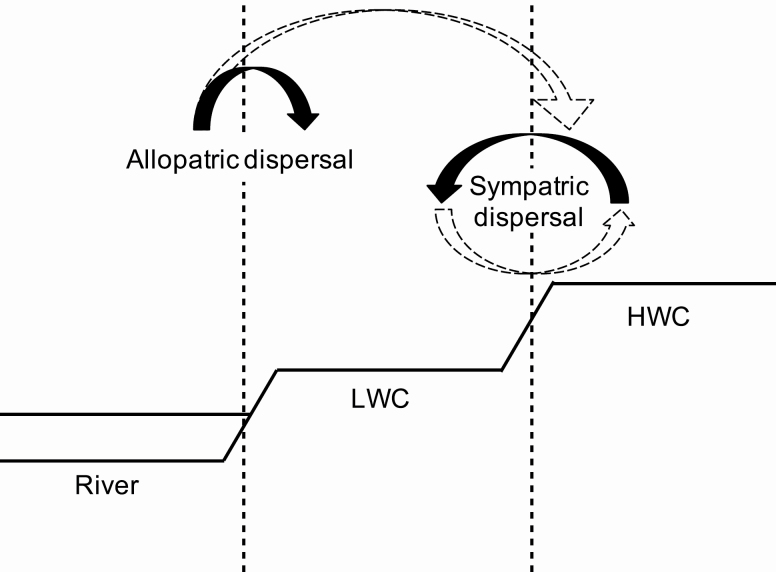
The image of migration flow in riparian area. Arrows indicated how migrants come.